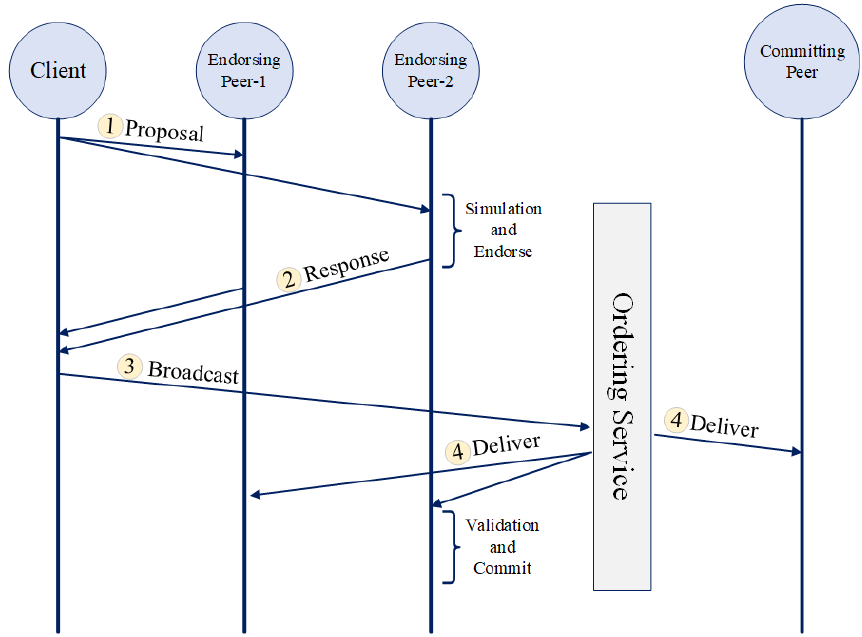
Figure 2. Fabric transaction